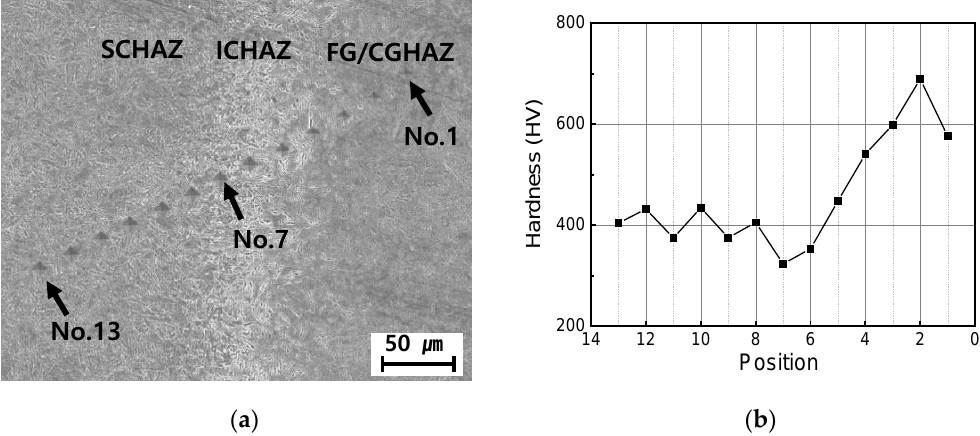
Figure 8. Nanoindentation hardness test result in ICHAZ and SCHAZ. ( a ) Indentation location and ( b ) measured hardness (welding speed: 7 m/min).